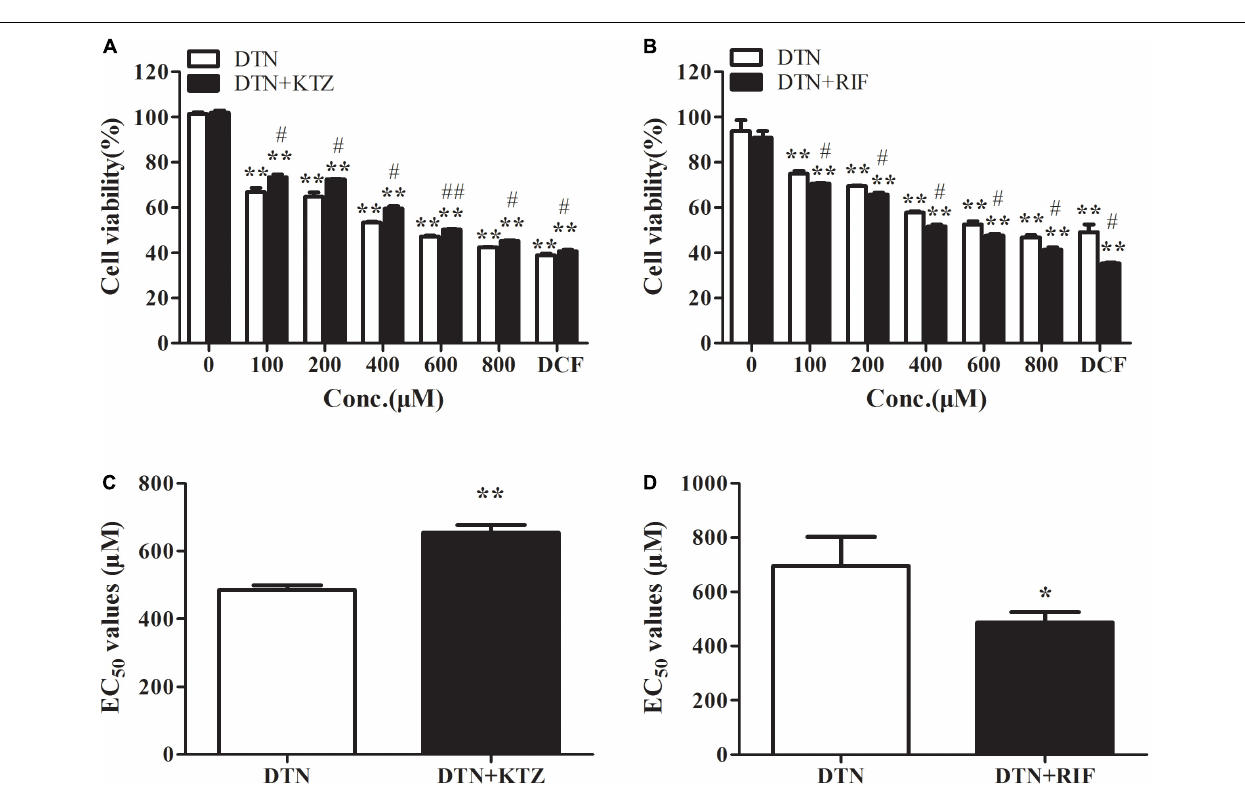
( Figure 4B ). Cytotoxicity of both DTN and DTN +